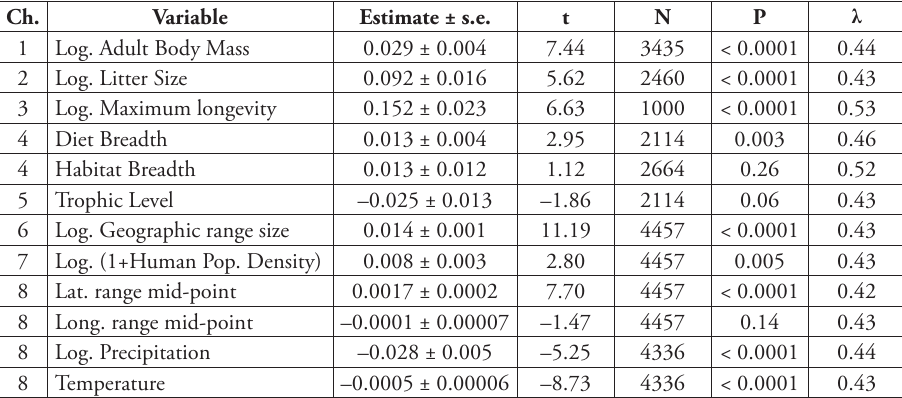
Table 4. Univariate phylogenetic generalised logistic models of the relationship between mammal spe- cies introduction and the variables in the second column. Ch. = characteristic of interest with which each variable is associated (see Introduction, Methods, and Table 1). Negative values of latitude relate to latitudes in the southern hemisphere. Negative values of longitude relate to longitudes west of the Green- wich Meridian. Estimate ± s.e. = regression coefficient ± standard error, Log. = natural logarithmically transformed, Lat. = Latitude, Long. = Longitude, Pop. = Population. λ = maximum likelihood estimate of Pagel’s lambda for the model.